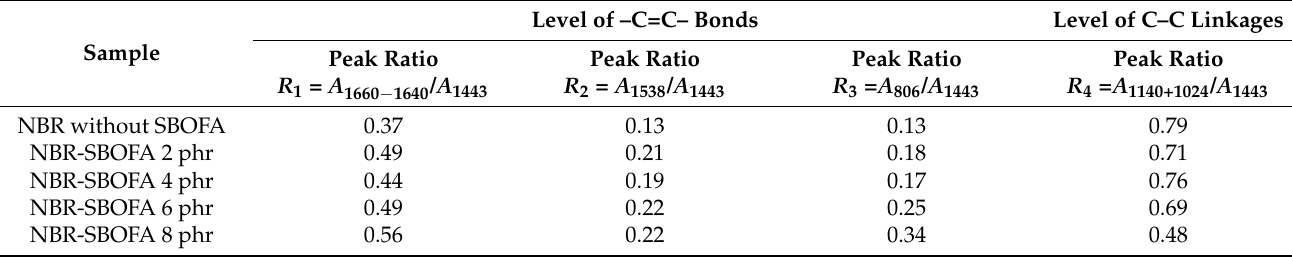
Figure 6. Representative ATR-FTIR spectra of NBR vulcanizates with varying SBOFA loadings. Table 4. Peak ratios of the ATR-FTIR spectra representing the level of double bonds (–C=C–) and new C–C linkage in the peroxide-vulcanized